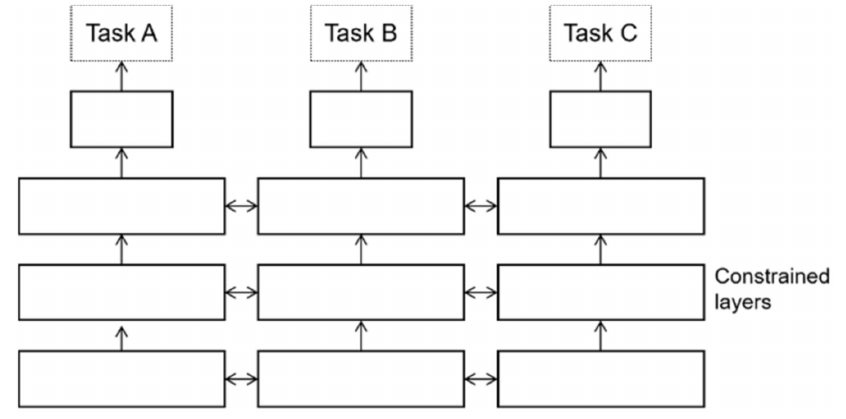
Figure 3. The soft parameter sharing method.